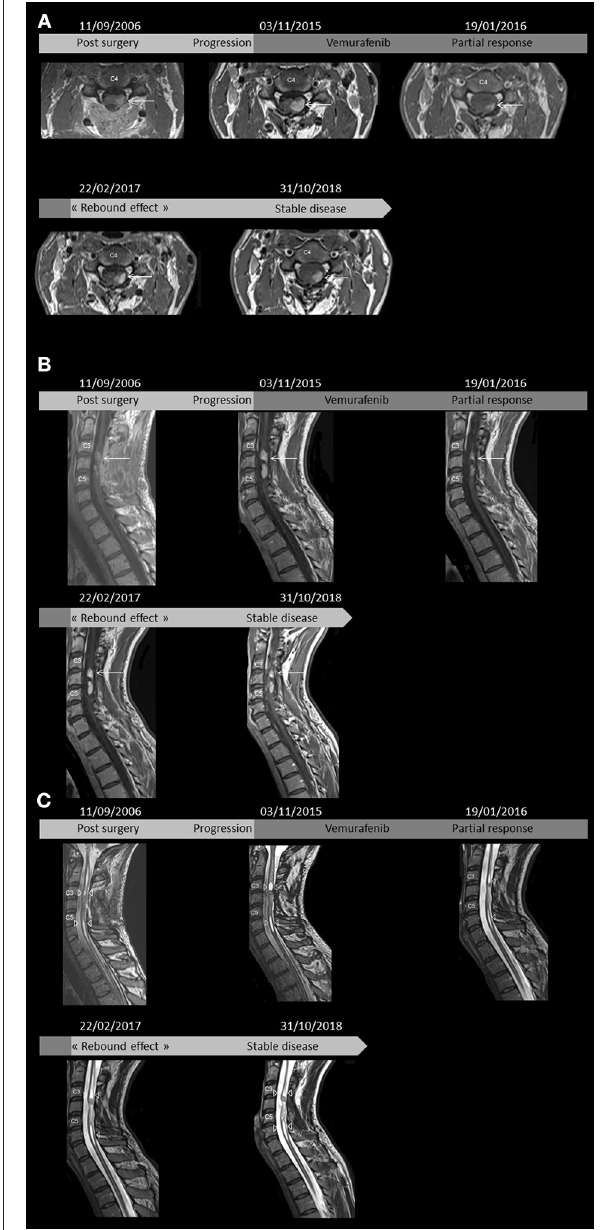
FIGURE 1 | Axial T1-weighted images between C3 and C4 of T1-weighted cervical spine magnetic resonance imaging (MRI) after gadolinium injection administration show dominant, patchy intense enhancing left-sided lesion within the spinal cord (arrows) 1 month after surgery, in pre-treatment with vemurafenib, 8 weeks after the beginning of vemurafenib, 2 months after vemurafenib discontinuation, and last follow-up (A) . Sagittal post contrast T1-weighted images revealed lesions between C3 and C4 as well as C4 and C5 (arrows) 1 month after surgery, in pre-treatment, 8 weeks after beginning treatment, 2 months after discontinuation, and last follow-up (B) . Sagittal T2-weighted images showing syringomyelia (arrowheads) rostral and caudal to the intramedullary tumor 1 month after surgery, at pre-treatment, 8 weeks after beginning treatment, 2 months after discontinuation, and last follow-up. Note the T2 hyperintensity in the spinal cord above and below the syringomyelia without associated enhancement (C)